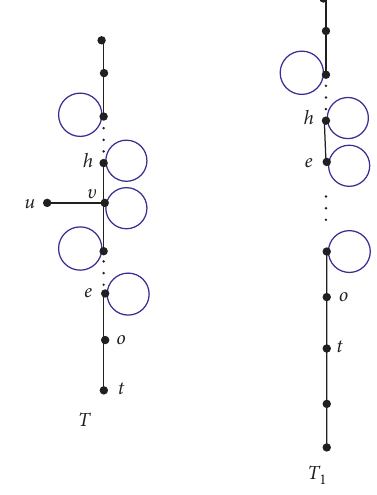
Figure 2: The trees T and T